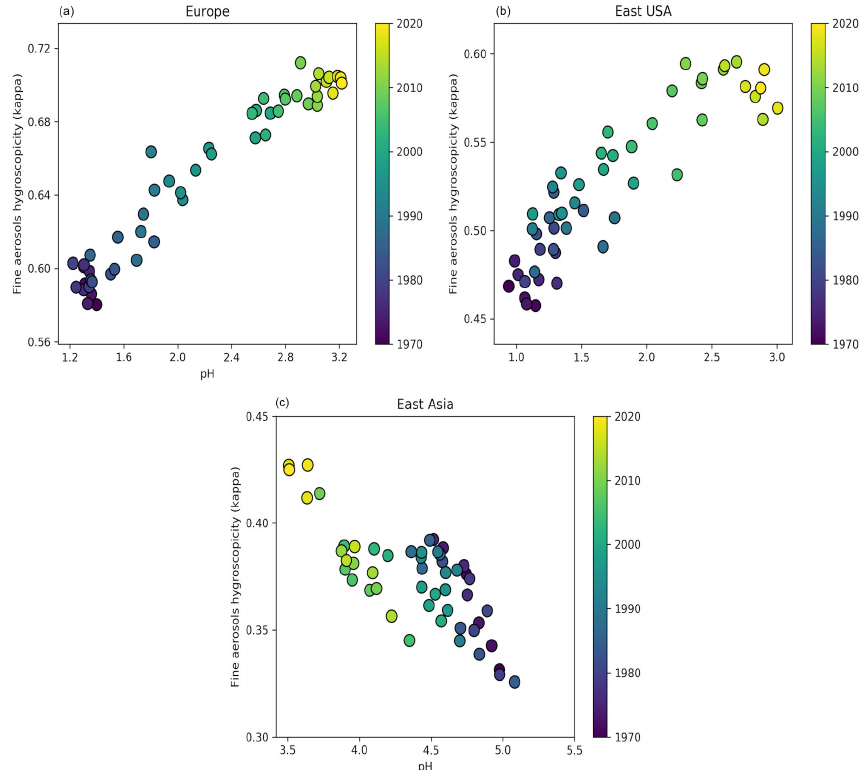
Figure 4. Time evolution of annual average aerosol hygroscopicity ( κ ) as a function of pH over Europe (a) , the eastern USA (b) , and East Asia (c) during the period 1970–2020 at the lowest cloud-forming level (940hPa).